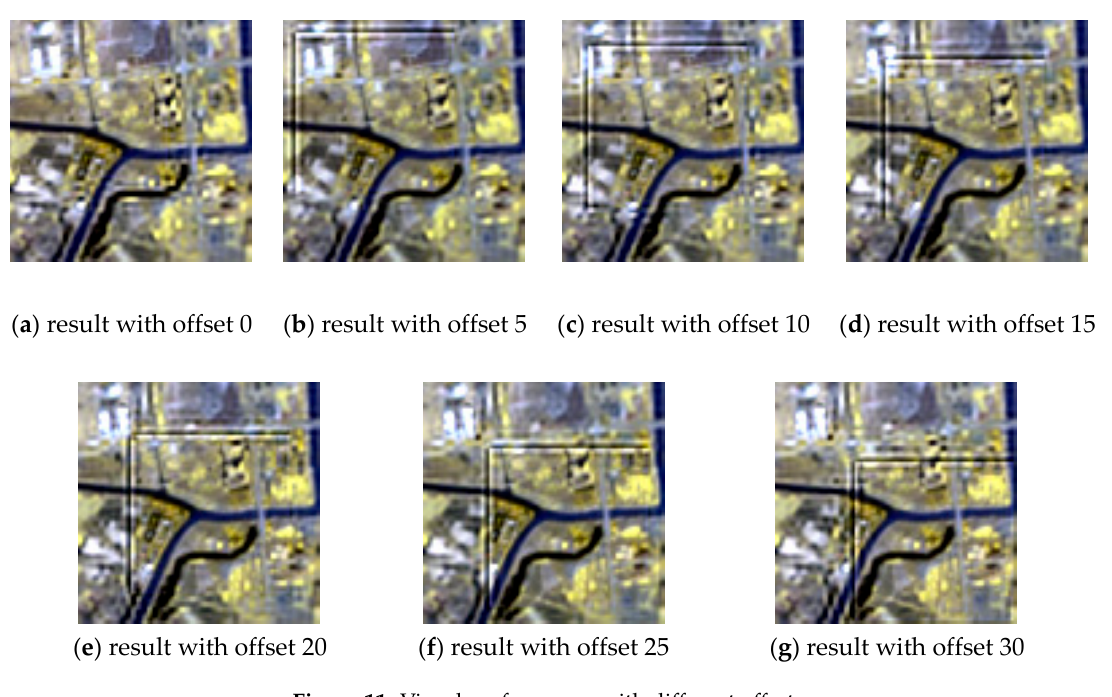
Figure 10. Quantitative evaluation results for different offset positions.